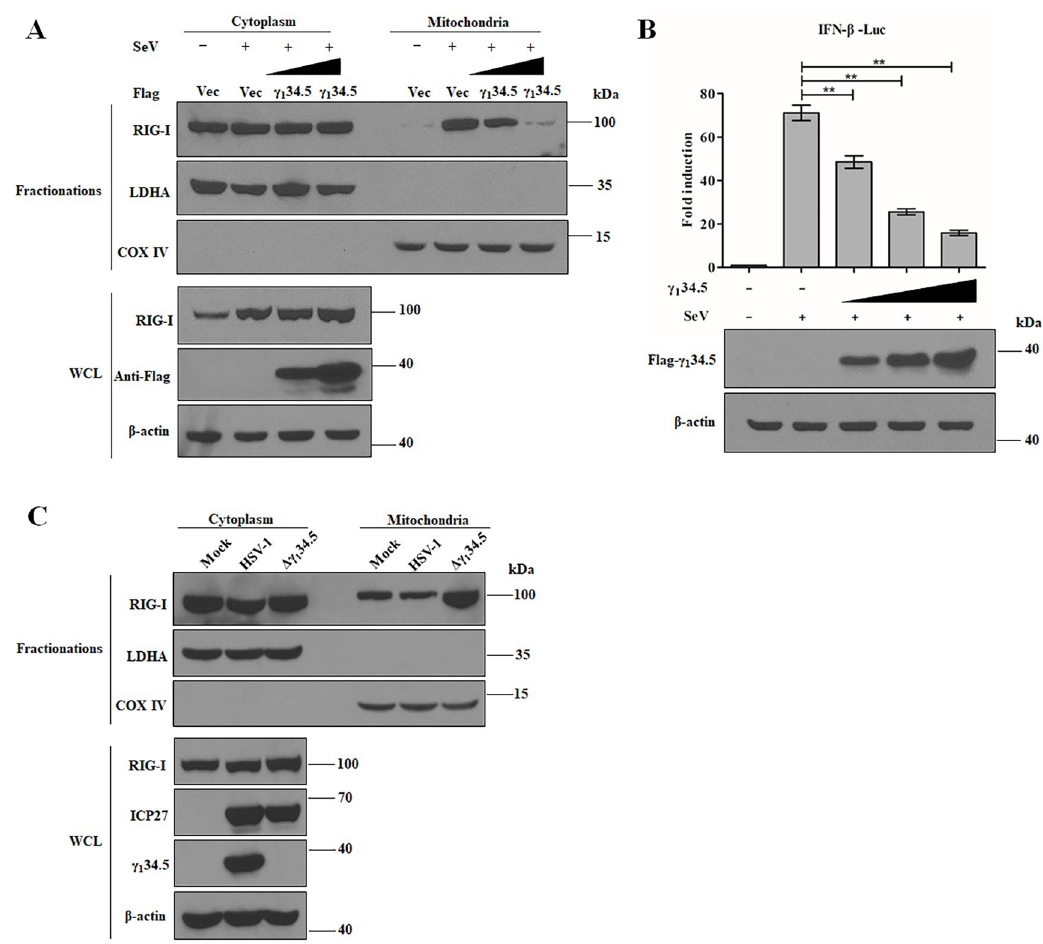
Fig 6. The γ 1 34.5 protein blocks RIG-I translocation to the mitochondria. (A) Ectopic expression of γ 1 34.5 inhibits RIG-I mitochondrial translocation in response to SeV infection. HEK-293T cells were transfected with empty vector (Vec) or increasing amounts of Flag- γ 1 34.5. At 24 h posttransfection, the cells were infected with SeV (100 HA/ml) for additional 24 h and harvested for cytoplasmic and mitochondrial fractionation. Samples were subjected to Western blot analysis with antibody against RIG-I, LDHA, COX IV and Flag. (B) The γ 1 34.5 protein inhibits IFN- β promoter activation by SeV. HEK-293T cells were co-transfected with pIFN- β -luc (50 ng) and pRL-TK (10 ng) along with either vector or Flag- γ 1 34.5 (range from 200 to 800 ng). At 24 h posttransfection, the cells were treated with SeV (100 HA/ml) for 24 h and harvested for luciferase assays. Results are expressed as means ± standard deviations (SD) ( n = 3) and assessed by one-way ANOVA ( �� , P < 0.01). (C) Block of RIG-I mitochondrial translocation by HSV-1 requires γ 1 34.5. MEF cells were mock-infected or infected with wild type HSV-1 or Δγ 1 34.5 (10 pfu/cell). At 8 h post infection, whole lysates, cytoplasmic and mitochondrial fractions were collected. Samples were processed for Western blot analysis with antibody against RIG-I, LDHA, COX IV, γ 1 34.5 and β -actin. The experimental data are representative of results from three independent